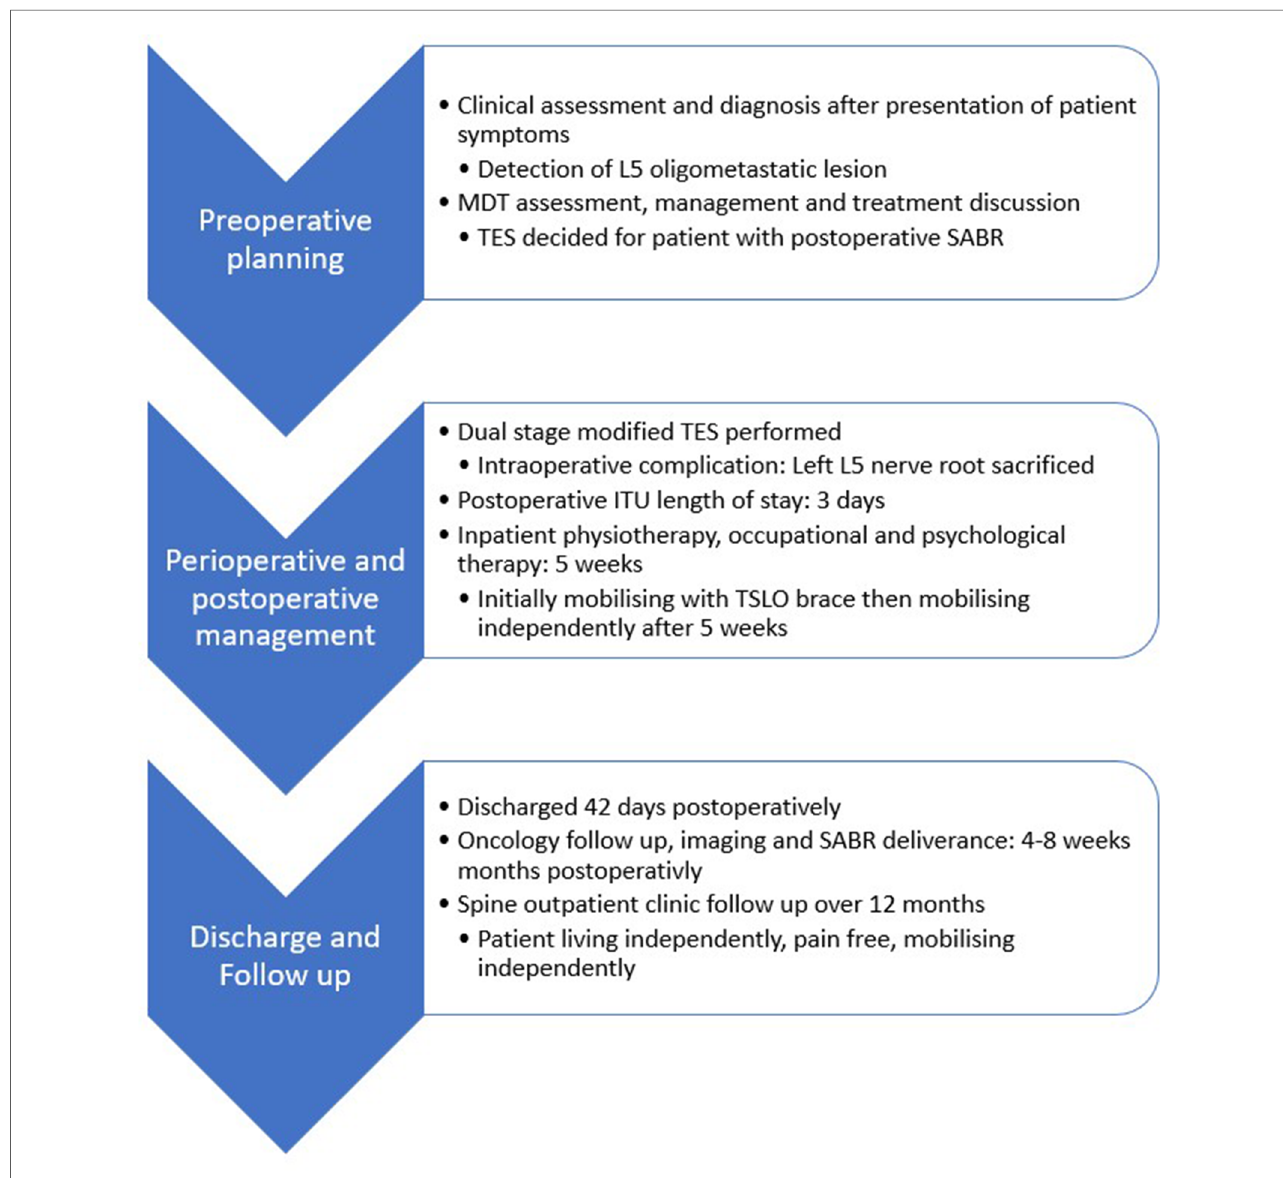
FIGURE 1 Patient Care